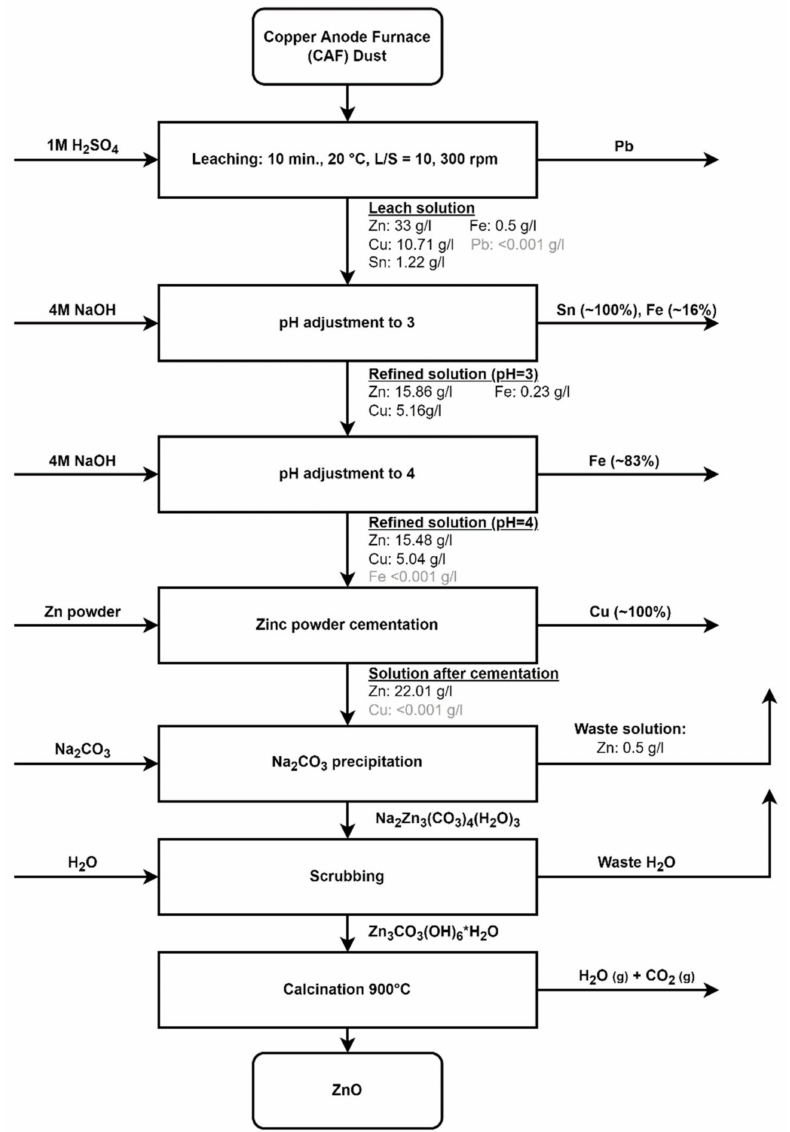
Figure 18. Copper Anode Furnace dust proposed recycling method consisting of leaching, solution refining, zinc precipitation and